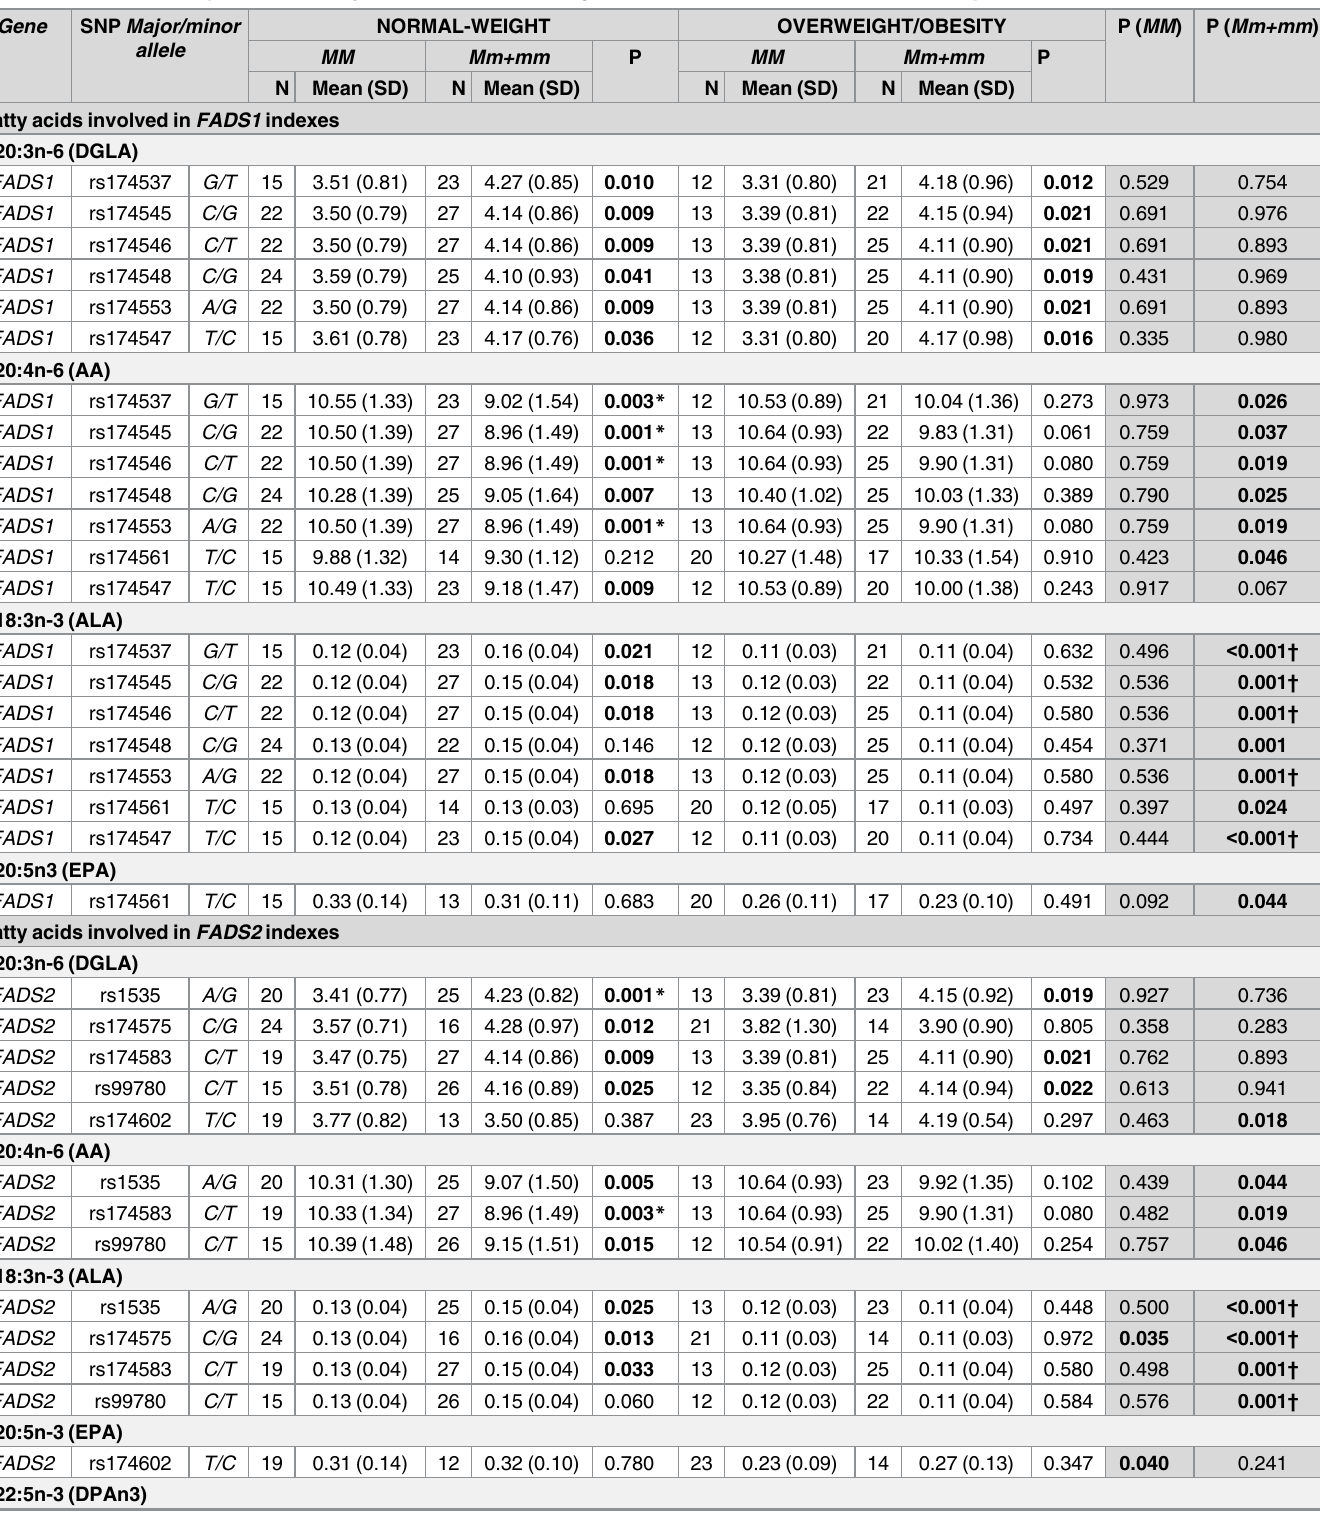
Table 5. Substrates and products of enzymatic indexes according to maternal SNPs and LC-PUFA levels in plasma. Gene SNP Major/minor allele